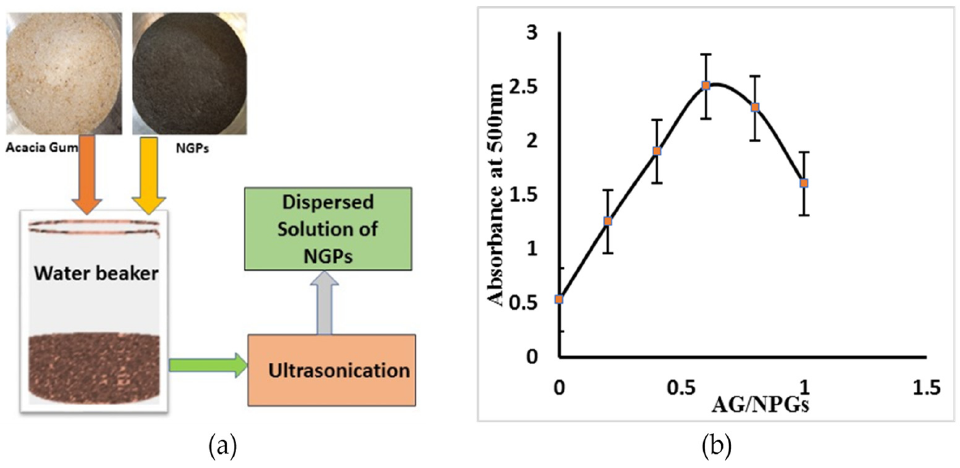
Figure 1. ( a ) Flow chart of NGP dispersion; ( b ) UV–Vis spectroscopy analysis results. Table 4. Dispersion scheme mix ratios. Table 5. Concrete mix proportions in Kg/m 3